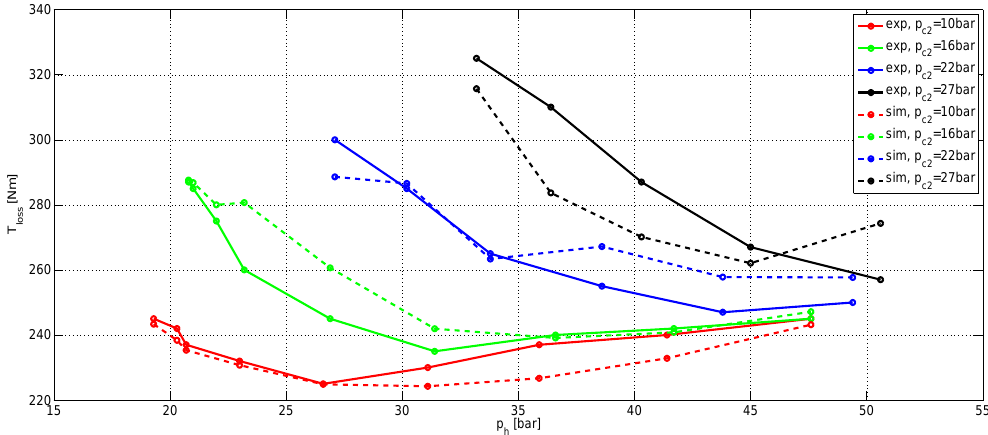
Figure 13: The simulated and experimental torque loss for the different p c 2 values.